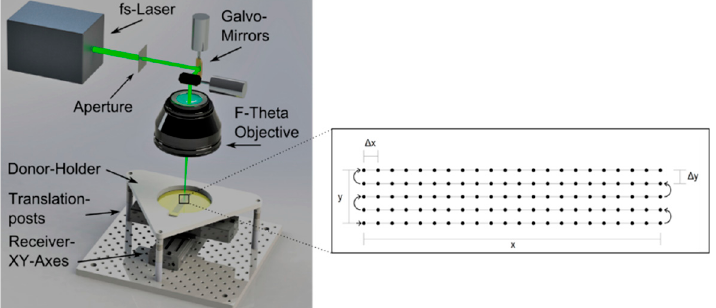
Figure 1. Schematic of the experimental setup and sketch of the typewriter similar receiver movement during the printing process.